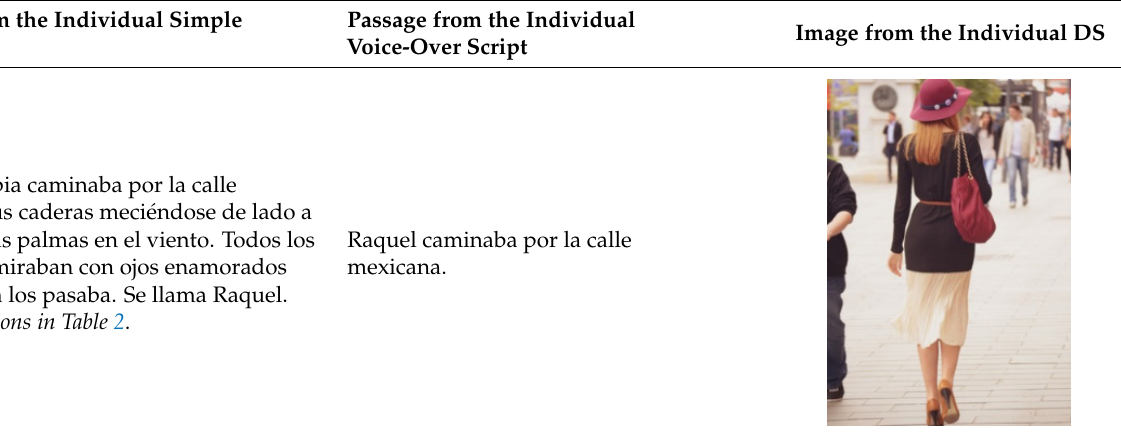
Table 3. Example of transduction: Olivia’s individual DS.